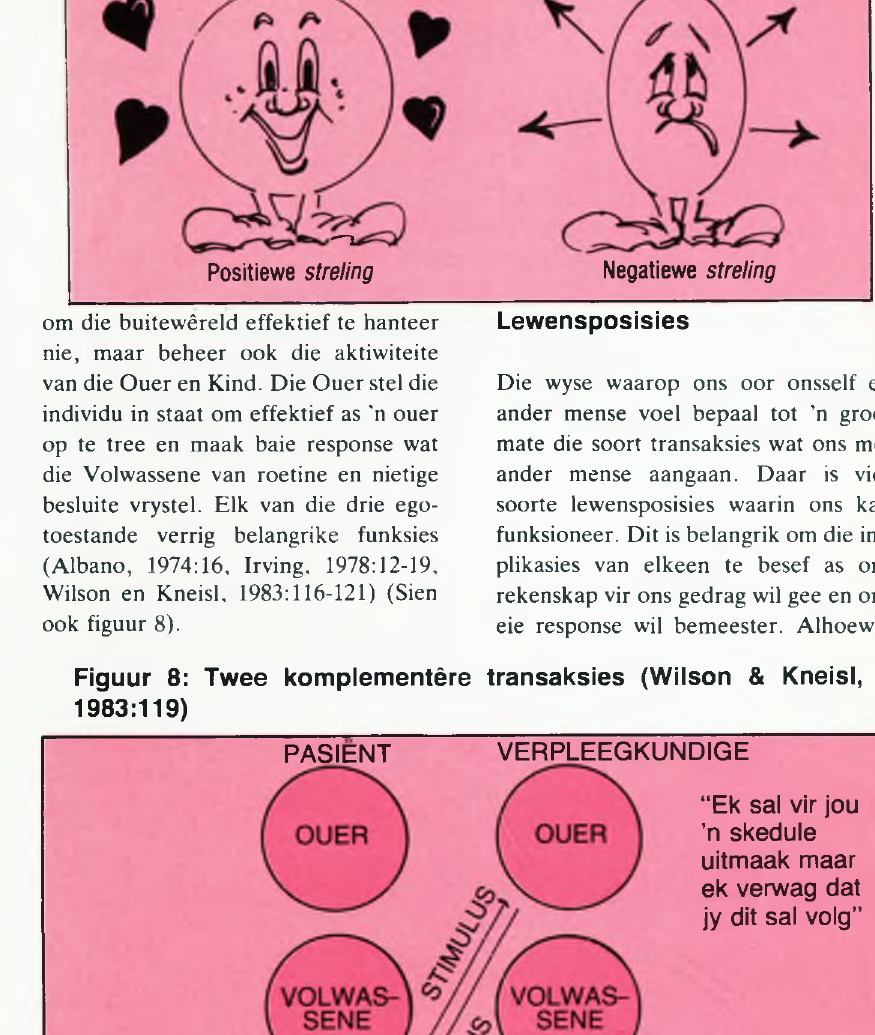
—L, Positiewe streling Negatiewe streling